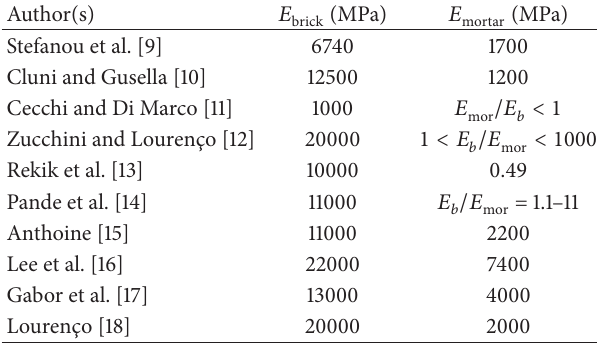
Table 1: Moduli of elasticity for